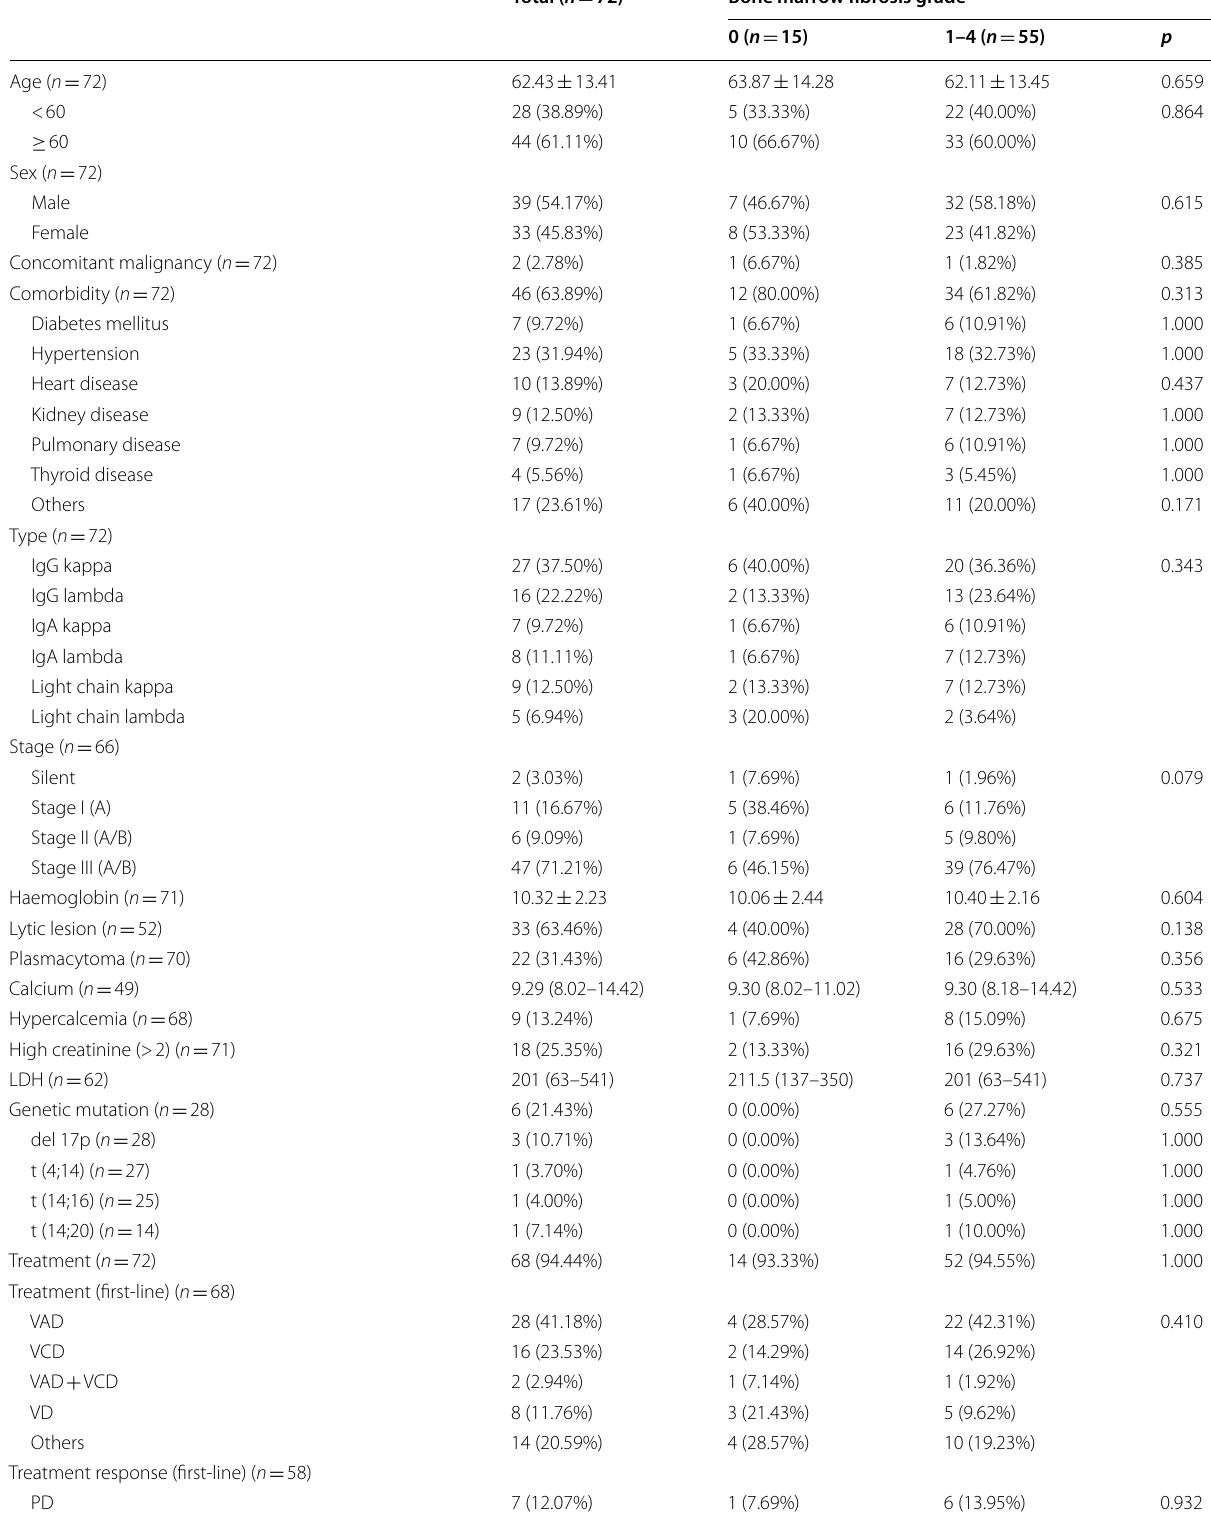
Table 1 Distribution of patients in the study group in terms of